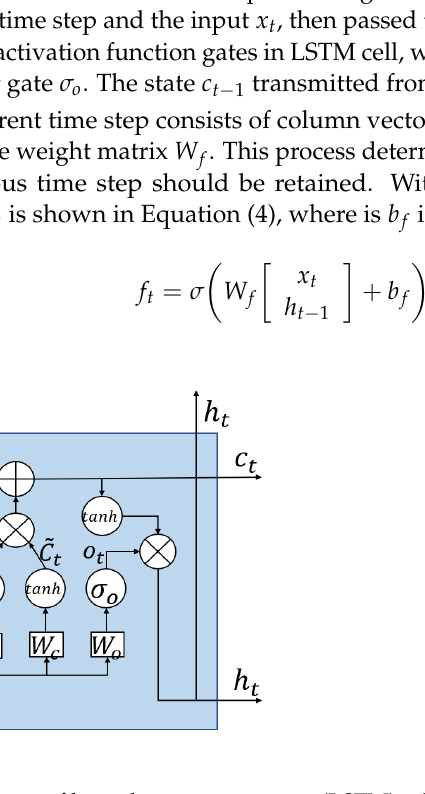
Figure 9. Basic structure of long short-term memory (LSTM) cell.